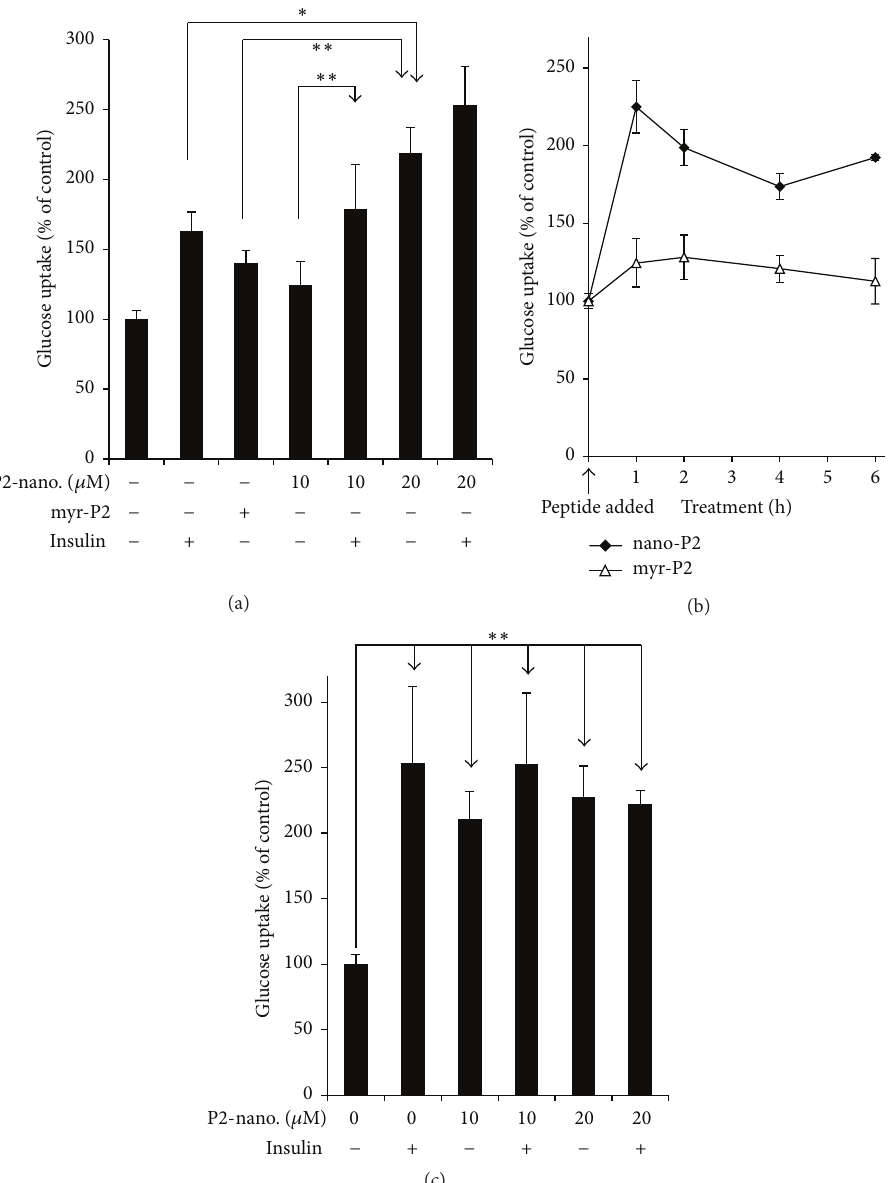
Figure 2: P2-nanoparticles induce glucose uptake in cells. (a) Nanoparticle delivery of peptide P2 (KYCCSRK) to human skeletal muscle (HSKM) cells stimulates glucose uptake. HSKM cells were grown in low glucose, low FBS medium overnight; then media were replaced with PBS containing 1% BSA for 1h. Cells were pretreated for 2h with 20 𝜇 M myristoylated P2 or with 10 or 20 𝜇 M P2-nanoparticles, followed by measuring 3 H-deoxyglucose uptake over a 15min interval. Insulin, when used, was added at the same time as 3 H-deoxyglucose. Each value is the mean ± sem of five samples. ∗ 𝑃 < 0.05 , ∗∗ 𝑃 < 0.01 . (b) Time course of glucose uptake stimulation by P2. HSKM cells were starved overnight as in (a). Medium was changed to glucose-free DMEM with 1% BSA for 1h prior to treatment with 20 𝜇 M myr-P2 or with P2-nanoparticles for the indicated times. Glucose uptake was measured as in (a), with each value being the mean ± sem of five samples. (c) P2-nanoparticles affect glucose uptake in HepG2 cells. HepG2 cells were starved in low glucose DMEM with 0.1% FBS overnight. Treatment with peptide nanoparticles was for 1h. Glucose uptake was measured as in